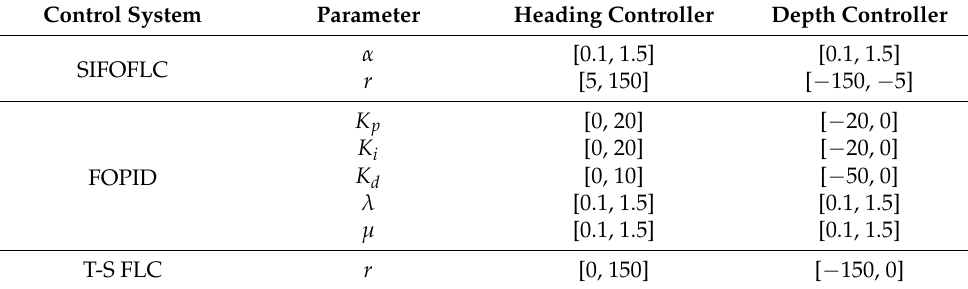
Table A1. Searching range of parameters for three control systems.